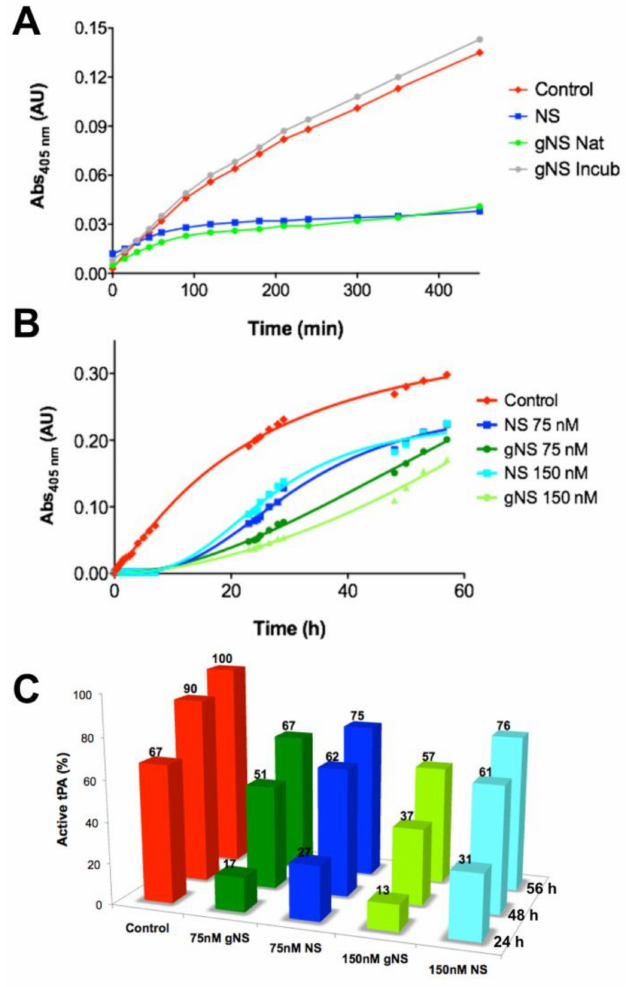
Figure 5. Comparison of tissue plasminogen activator (tPA) inhibition by NS and gNS. ( A ) tPA activity tests in the absence (red) and presence of 60 nM of NS (blue), native (green) or incubated for 24 h at 45 ◦ C (grey) gNS. ( B ) The ability of gNS and NS to inhibit tPA at two di ff erent concentrations (75 and 150 nM) was compared. ( C ) The inhibitory e ffi ciency of gNS or NS is reported in comparison to the control reaction. The activity of tPA in the positive control after 56 h is set to 100% and all other values have been normalised accordingly. In the control reaction, no gNS or NS was